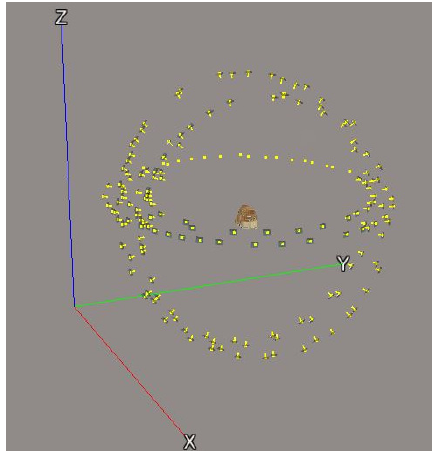
Figure 9. ContextCapture image orientation of the fragment with Komòs